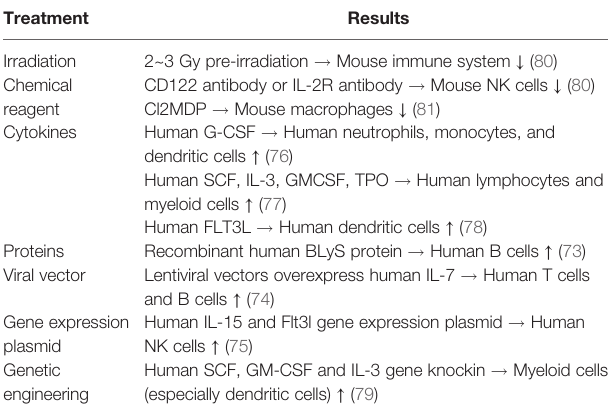
TABLE 3 | The improvement of humanized SLE mice. Treatment Results Irradiation